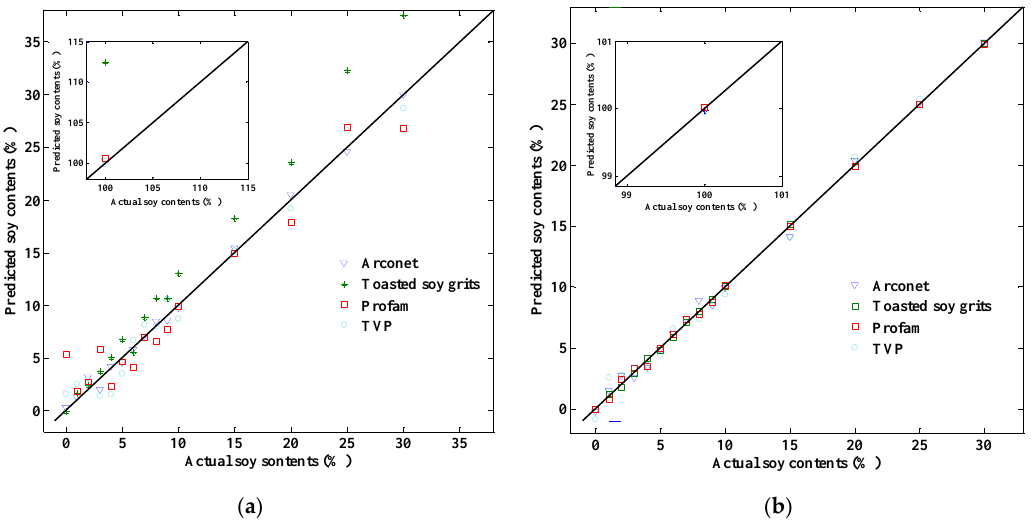
Figure 3. Predicted versus actual soy contents in ground beef using PLS regression model. ( a ) Model developed by dispersive NIR spectra; ( b ) Model developed by FT-NIR spectra, PLS: partial least squares.